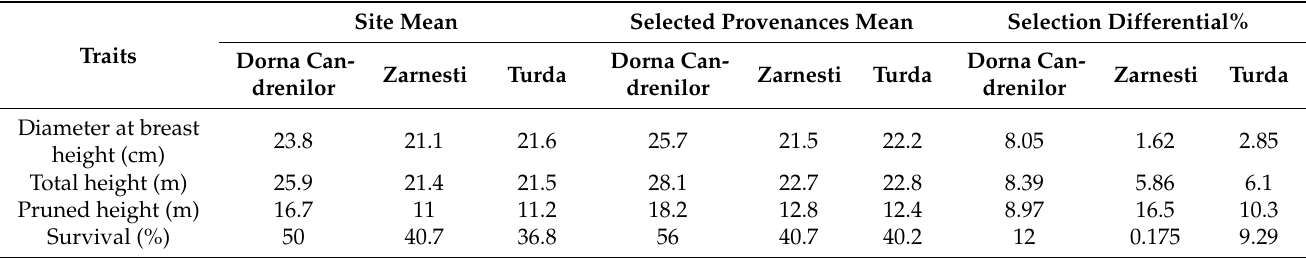
Table 3. The selection differential of MGIDI index for Norway spruce provenances at 48 years